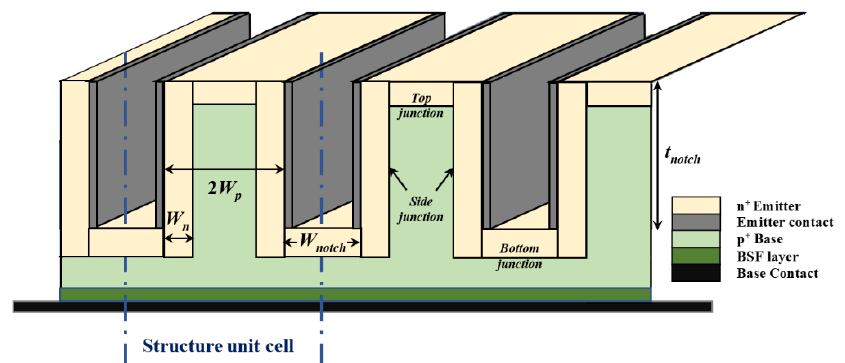
Figure 1. 3D schematic representation of the partially-filled-notches npn solar cell microstructure utilized in the study.